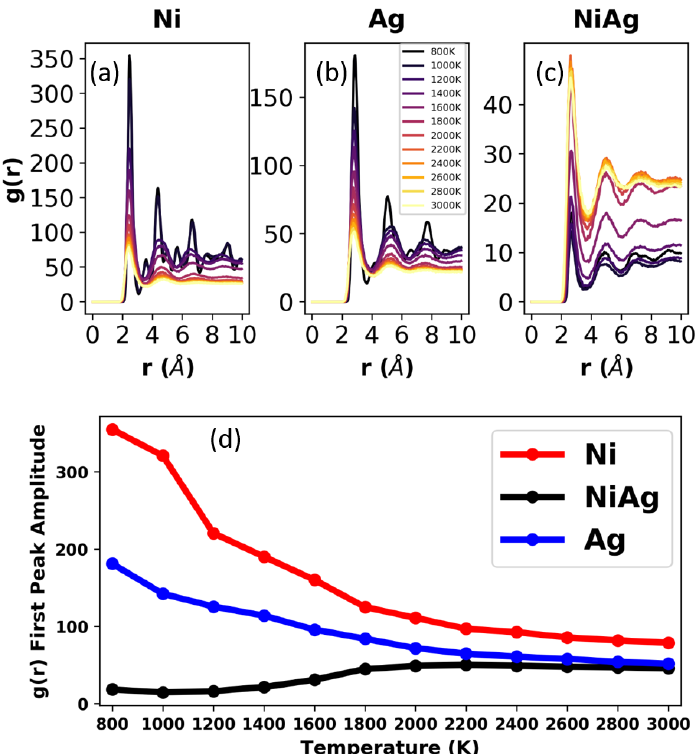
Figure 6. RDFs for the droplets at all temperatures for Ni ( a ), Ag ( b ), and NiAg ( c ). ( d ) Plot of the amplitude of the first peak (located between radii of 2 and 3 angstroms), as a function of temperature for Ni, Ag, and NiAg.